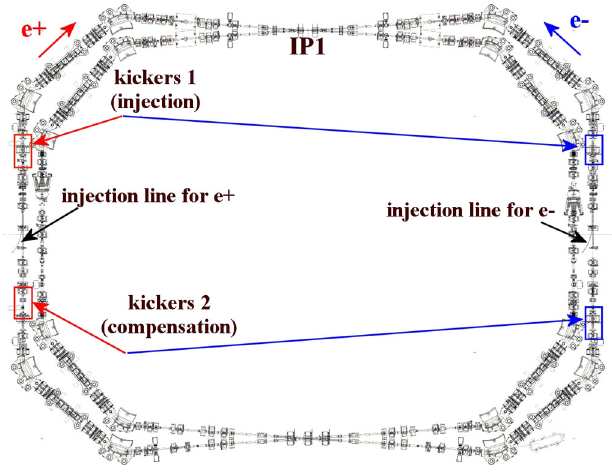
FIG. 1. Sketch of the DA(cid:1)NE rings with injection system.